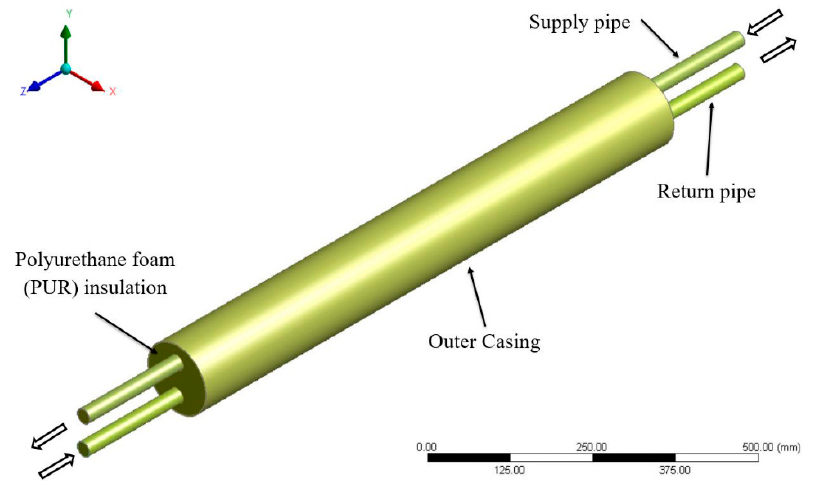
Figure 1. Schematic of a piece of a twin-pipe.